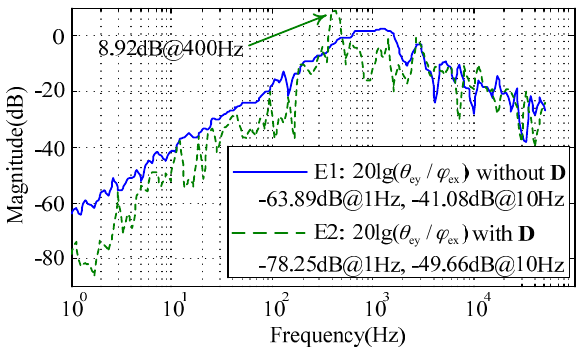
Figure 12. Experimental results with the inner-loop compensation. The angular position coupling is reduced by 14.36 dB at 1 Hz and 8.58 dB at 10 reduced by 14.36 dB at 1 Hz and 8.58 dB at 10 Hz.